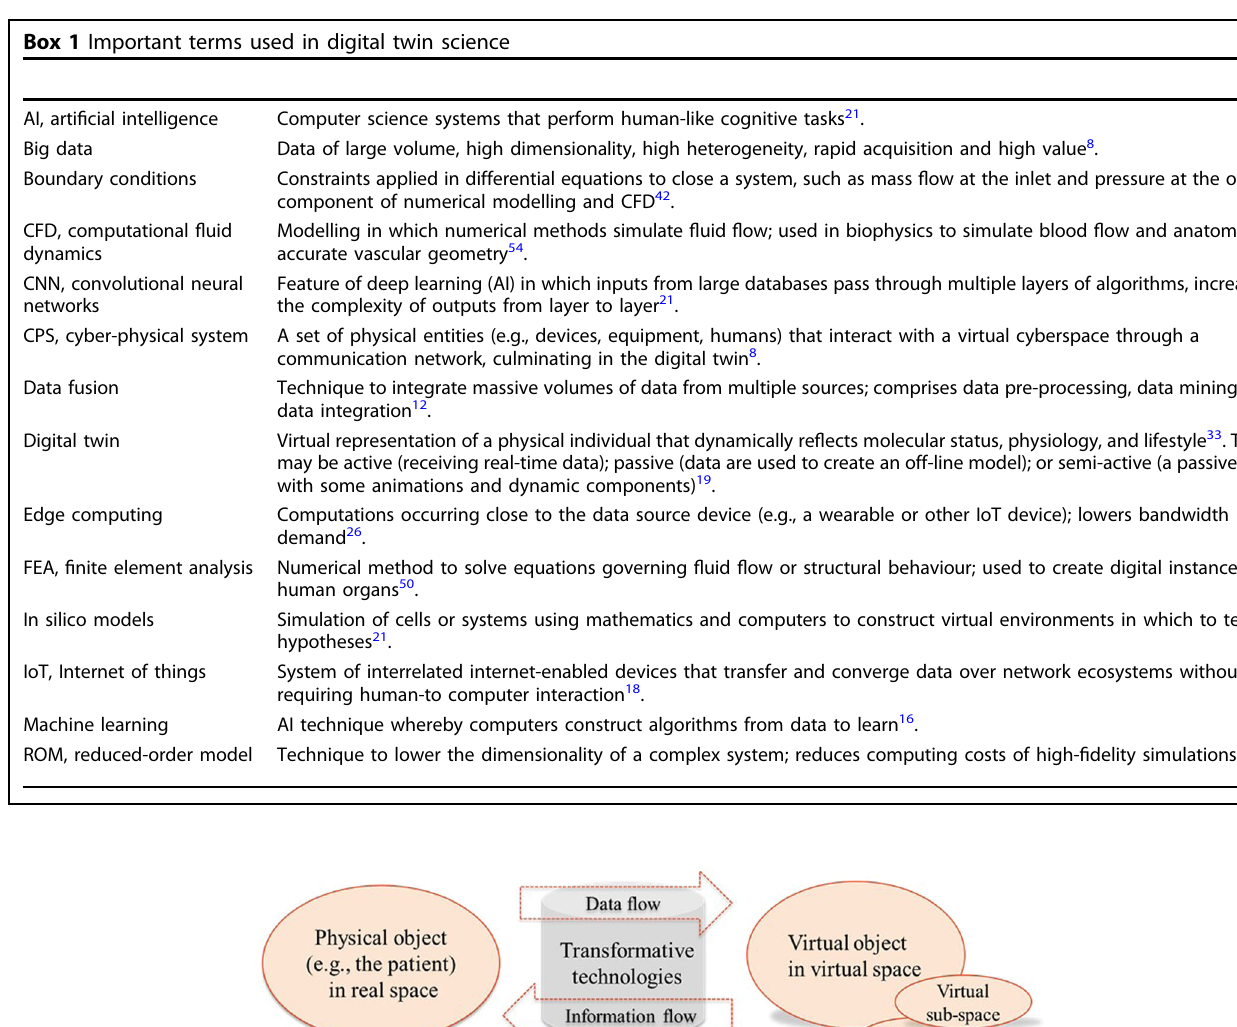
(Table 1). Common to the methods used were simulation and modelling techniques from computing, bioengineering and math- ematical sciences. The original research papers were best described as proof of concept and model validation; none were fully integrated into routine clinical practice, although seven were described as precursors to either an active or semi-active digital twin (Fig. 3). Nine discussion-type papers broadly examined precision cardiology in terms of machine-learning-based applications, combined statistical and mechanistic modelling techniques, clinical acceptability, transla- tion, potential bene fi ts, and limitations. In terms of scale, the digital twin elements were mostly applied at the organ level, modelled using one or more structural, biomechanical, and electrical characteristics of the heart derived from echocardiographic, tomo- graphic, magnetic resonance and other imaging; also, electrocardio- gram (ECG) databases and mathematical models. Two twin models using ‘ human ’ characteristics at the scale of a virtual patient incorporated descriptive data from health records and prospective biometric and behavioural data from smart wearables or other devices. One of the studies 25 created a databank of pro fi les from